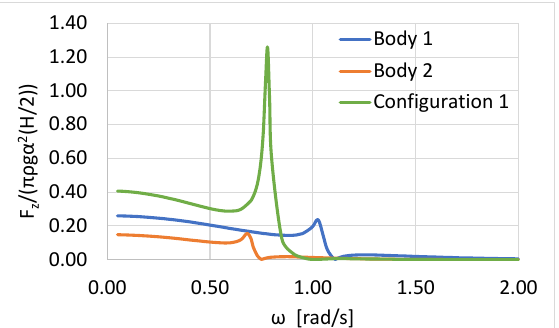
Figure 5. Horizontal exciting forces on the Configuration 1. The results are also compared with the corresponding forces on the isolated toroidal Bodies 1 and 2.